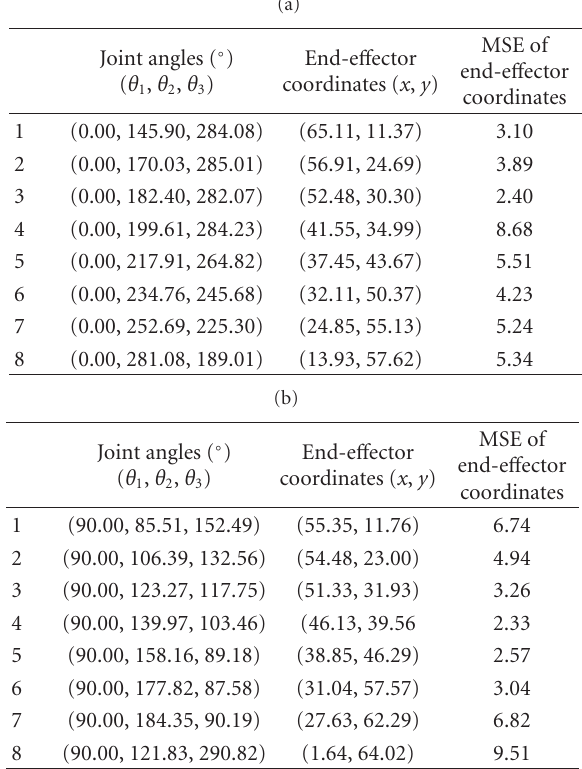
Table 4: Estimated joint angles, calculated end-e ff ector coordi- nates, and errors with (a) regularization F 1 ( x ) and (b) regulariza- tion F 2 ( x ), for ill-posed problem of